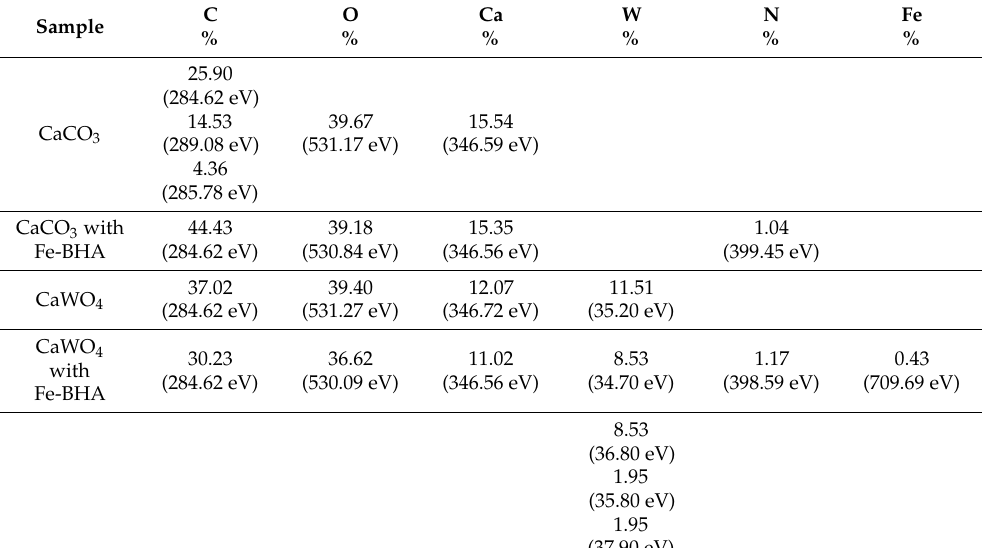
Table 3. XPS analyses of scheelite and calcite before and after contact with Fe-BHA.